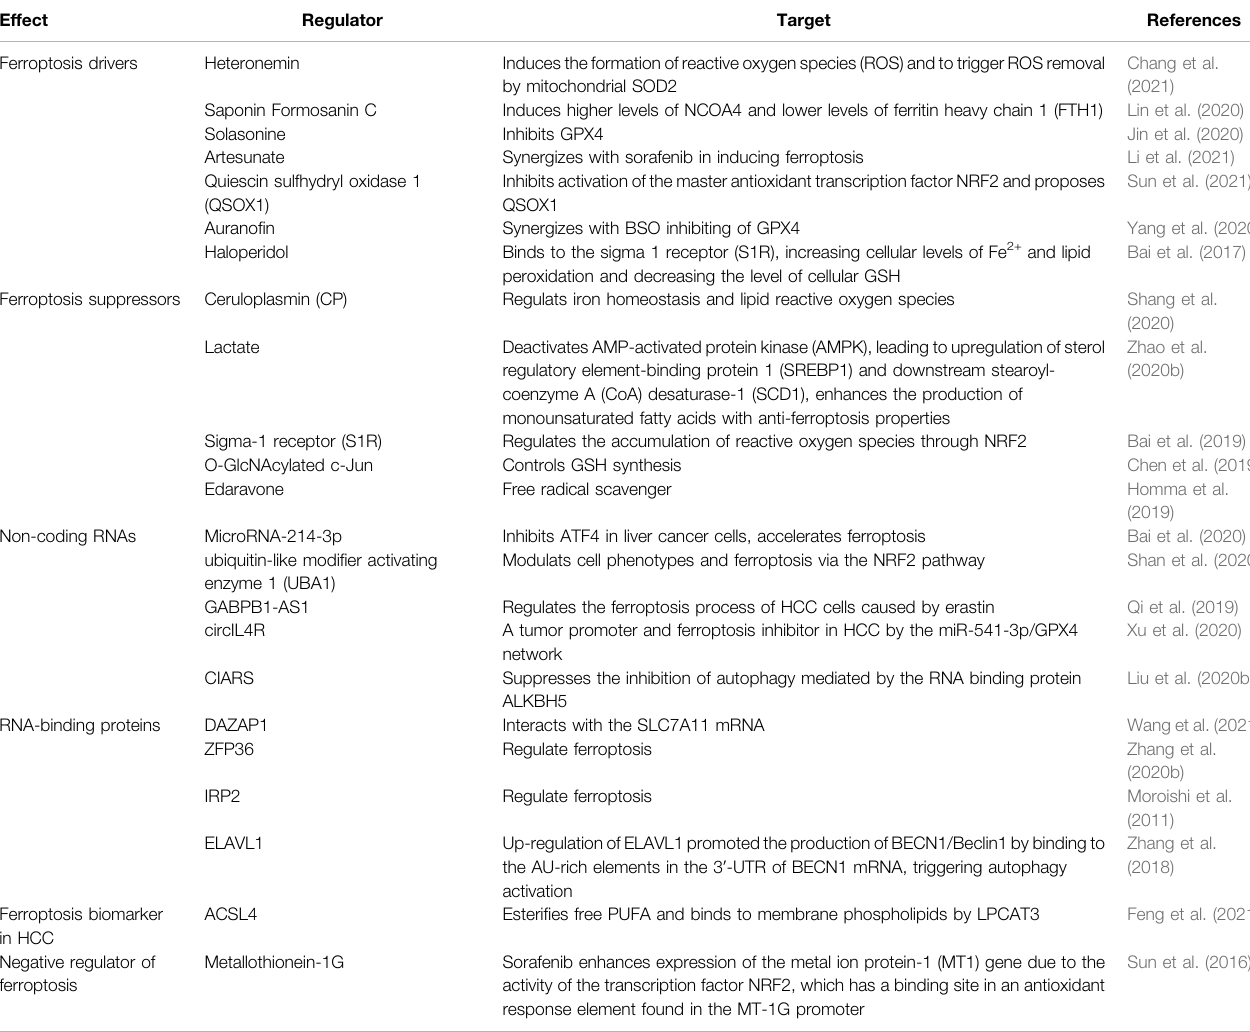
TABLE 3 | Regulators of ferroptosis in